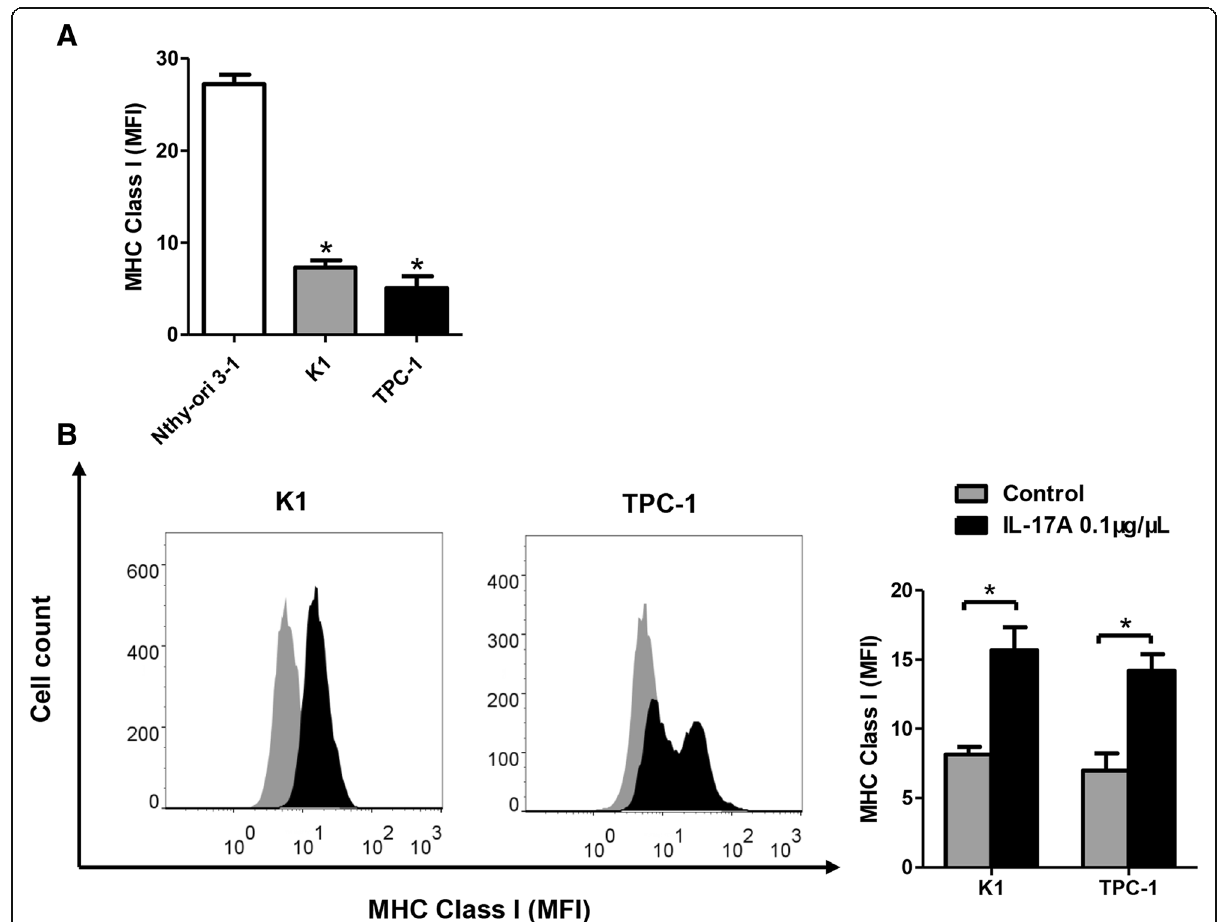
Fig. 3 IL-17A upregulates MHC Class I expression in PTC cell lines. a , Mean Fluorescence Intensity (MFI) of MHC Class I molecules in normal human thyroid cell line Nthy-ori 3 – 1, PTC cell line K1 and TPC-1. ( * P < 0.05) b , the effect of 0.1 μ g/ μ L IL-17A stimulation for 24 h on MHC Class I expression of K1 and TPC-1 cells measured by flow cytometry. ( * P <